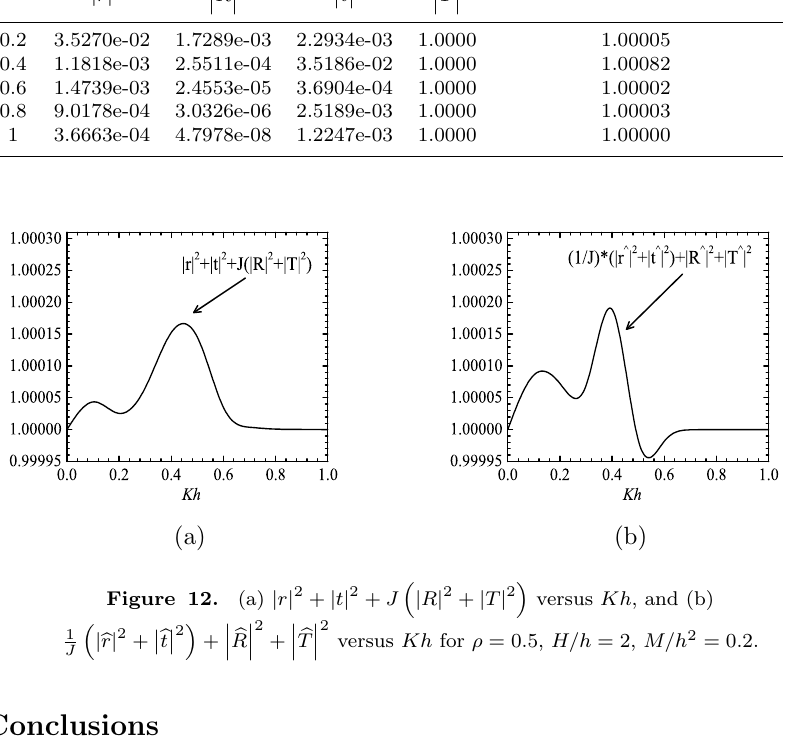
Figure 12. (a) | r | 2 + | t | 2 + J (cid:16) 1 | (cid:98) r | 2 + (cid:12) (cid:12)(cid:98) t (cid:12) (cid:12) 2 J